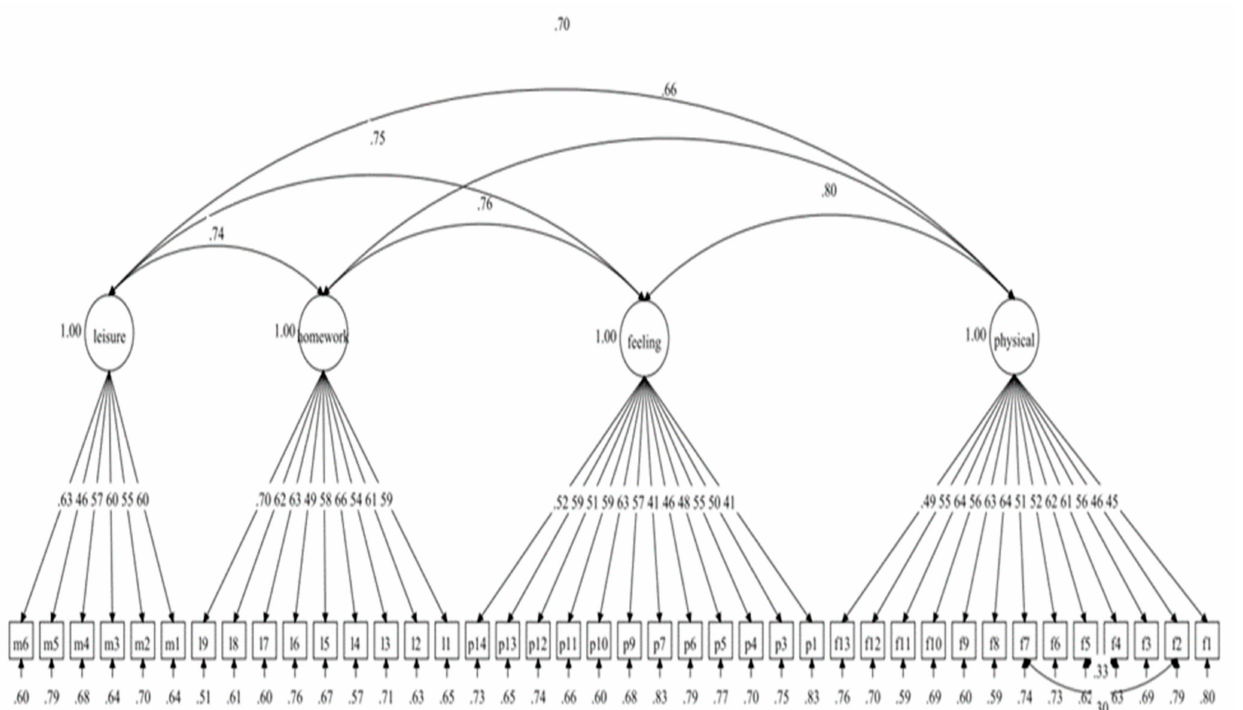
Figure 1. The confirmatory factor analysis (CFA) diagram for the final measurement model of the